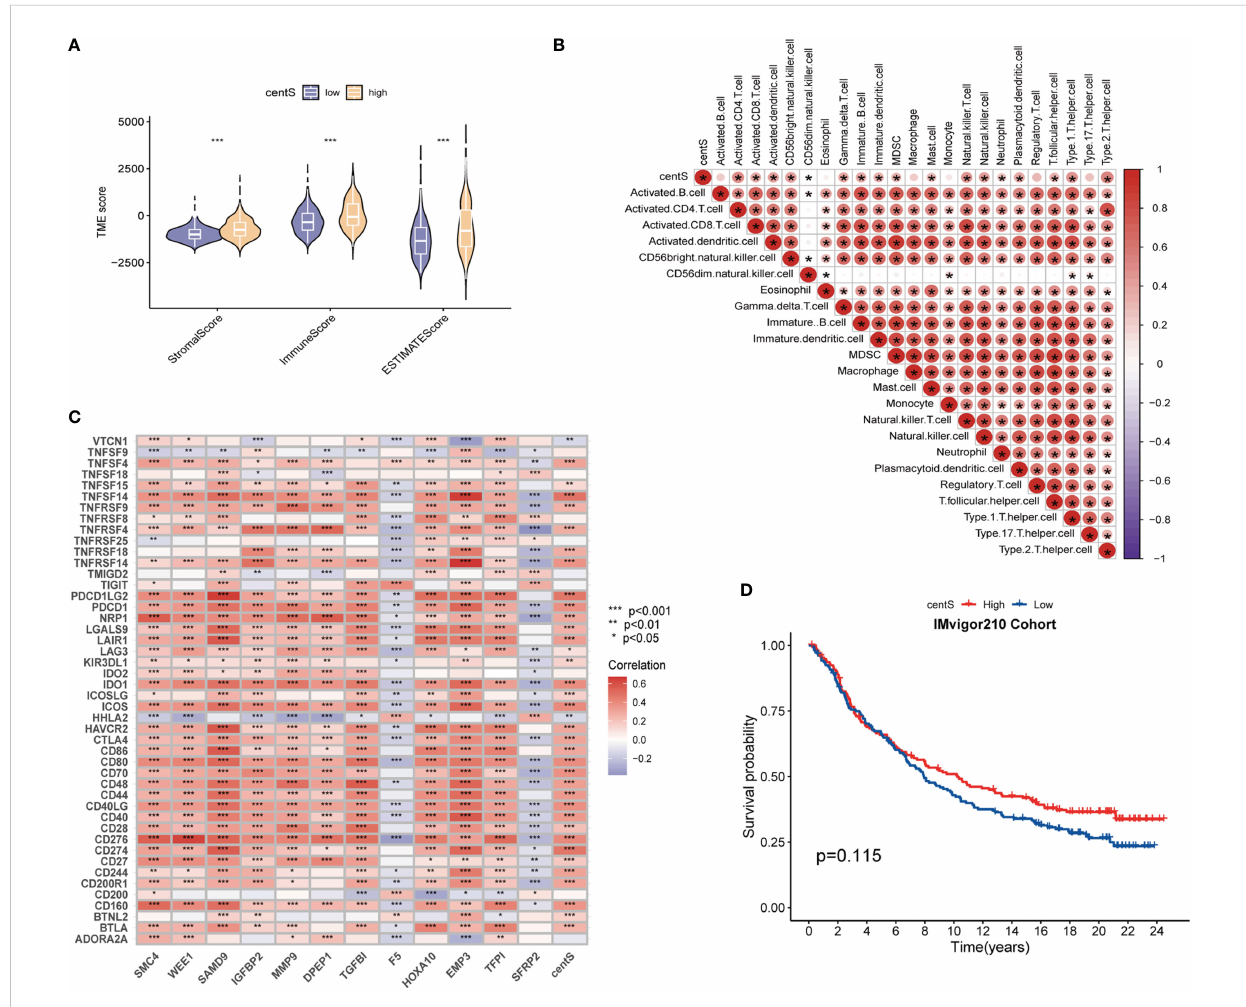
FIGURE 8 Tumor Immune microenvironment analysis base on centS. (A) Violin diagram for difference comparison of StromalScore, ImmuneScore, and ESTIMATEScore in the low- and high-centS groups. (B) Correlation heat map of centS and 23 immune cells based on ssGSEA. (C) Co-expression heat map of the 12 signature genes and centS with 46 ICGs. (D) OS analysis based on centS grouping in IMvigor210 Cohort. centS, centrosome score; ICGs, immune checkpoint genes. *p < 0.05; **p < 0.01; and ***p <